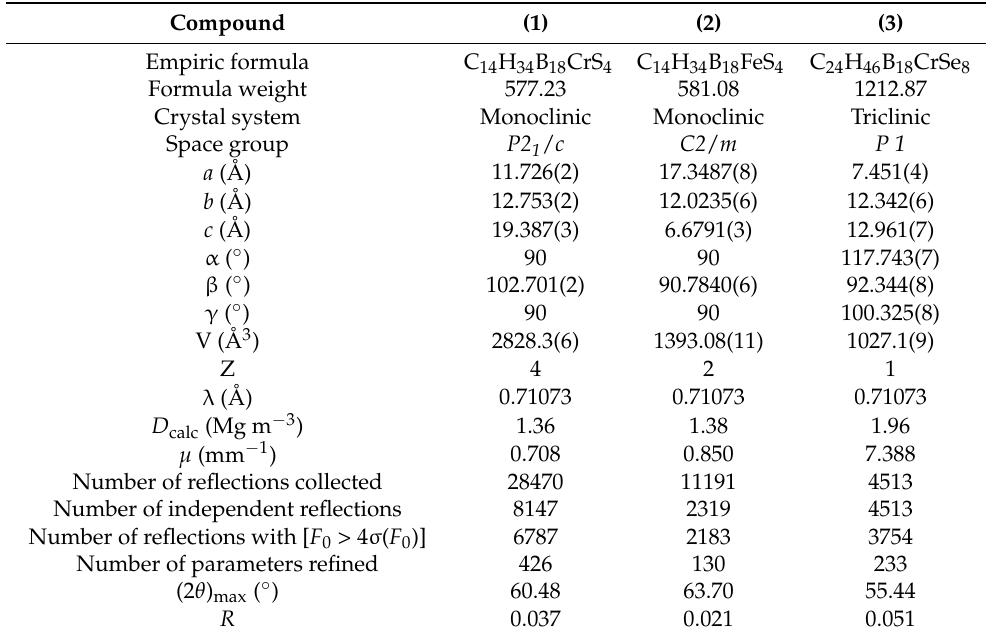
Table 1. Crystal data and structure refinement for (TMTTF)[3,3 (cid:48) -Cr(1,2-C 2 B 9 H 11 ) 2 ] ( 1 ), (TMTTF)[3,3 (cid:48)